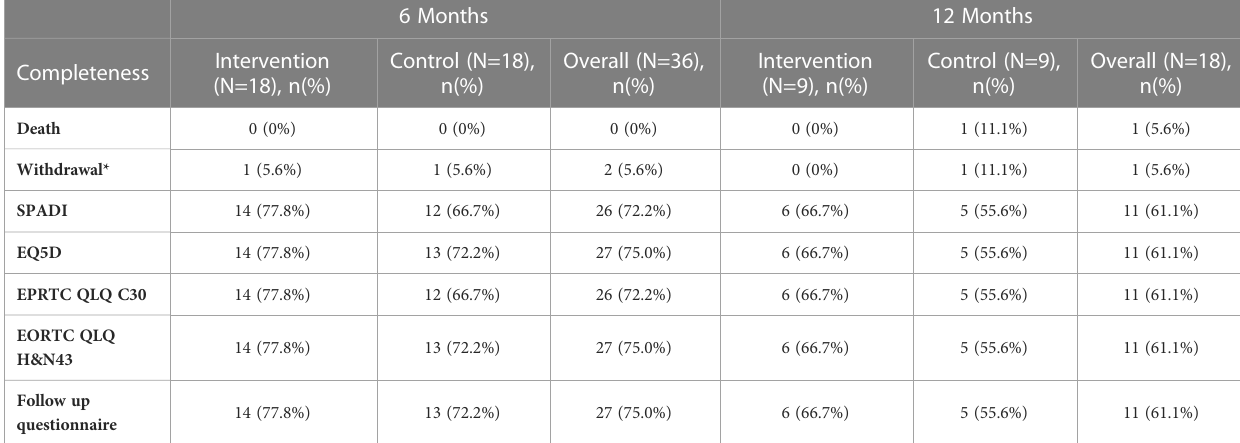
TABLE 4 Data completeness at six and 12-months